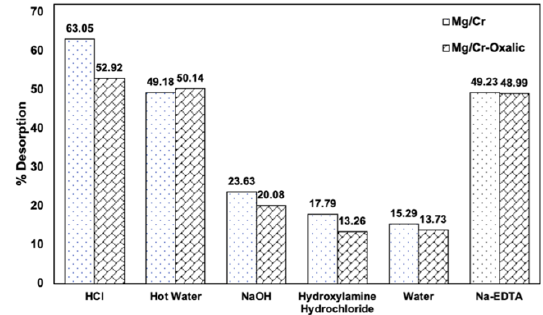
Fig. 7. Desorption malachite green on Mg/Cr LDH and Mg/Cr-Oxalate LDH The adsorbent regeneration was carried out using HCl as a desorption reagent to release the malachite green after the adsorption process.